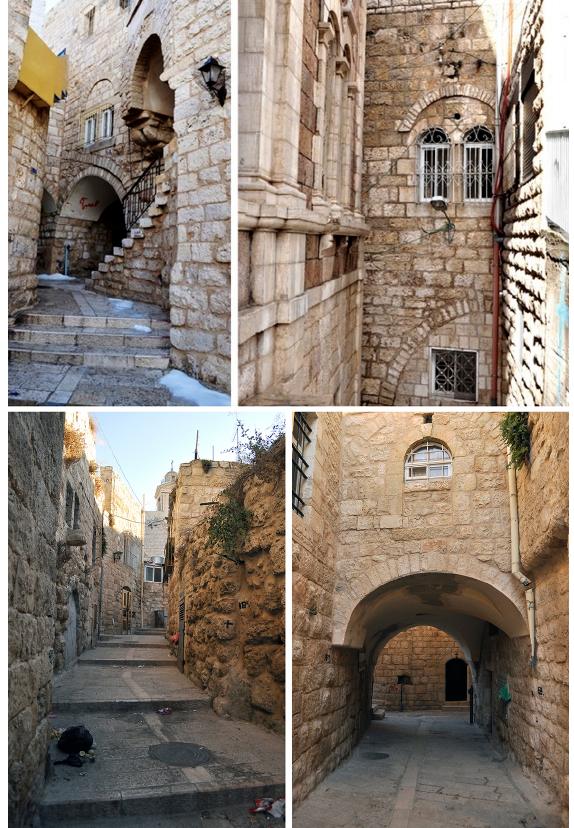
Figure 2: Inner paths of Al-Anatreh, analysis and strategy definition for close-range survey campaign acquisition from the ground.